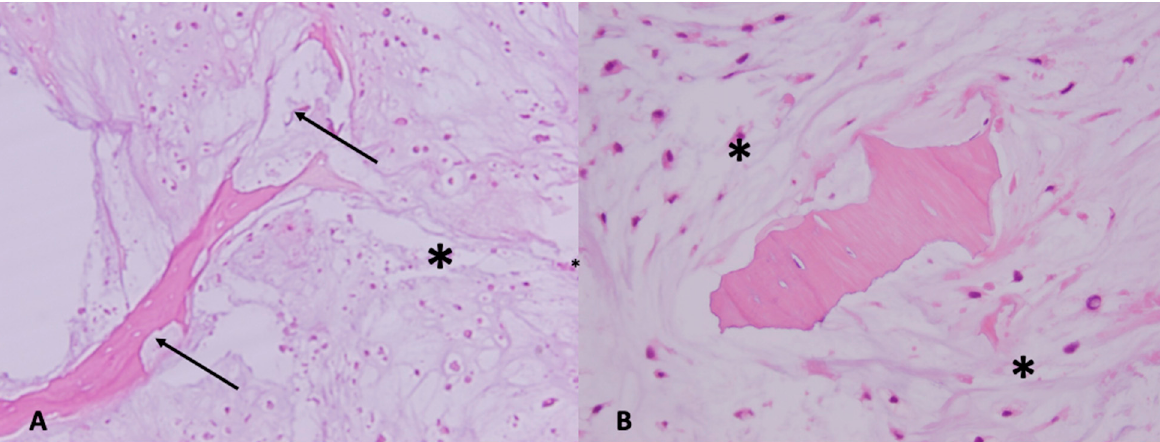
Figure 4. Microscopic images showing cartilaginous matrix-producing tumor (*) with permeation into the bone (1( A ) H&E ×100; arrow) and entrapping the pre-existing lamellar bone (1( B ) H&E ×200).